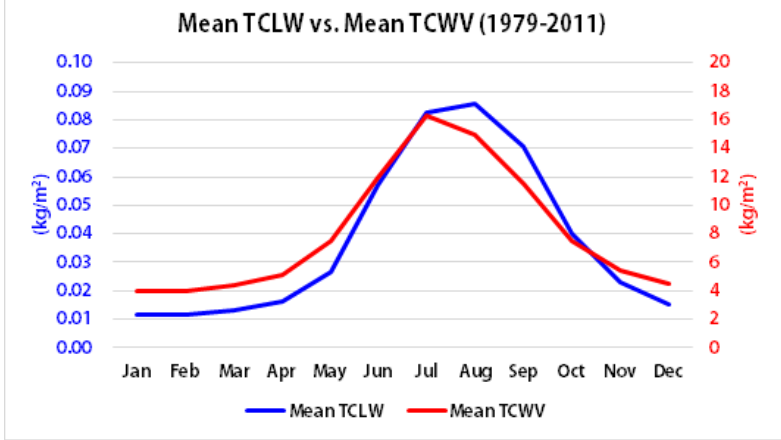
Figure 4. Monthly mean total column liquid water (TCLW) and total column water vapor (TCWV) during 1979–2011. The values for the entire pixels were aggregated.